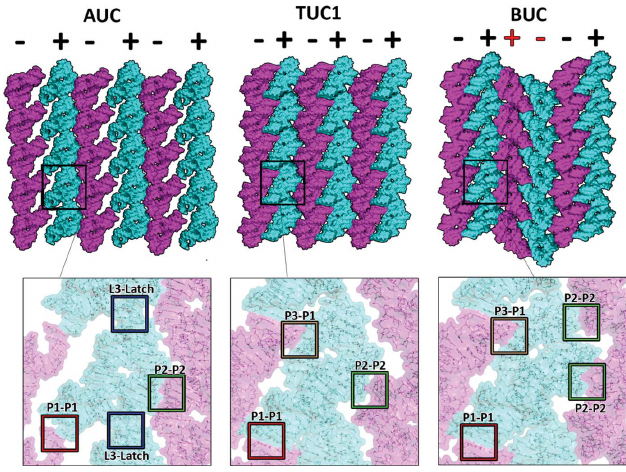
Figure 2 Comparison of the orientations of riboA molecules in the ac plane of each crystal phase, AUC (left), TUC1 (middle) and BUC (right), and their respective crystal packing interfaces. The lattice plane can be described as columns of riboA molecules, each of which has an associated direction (+ or (cid:5) ) based on the way the molecules are facing. Red + and – highlight the change in orientation of the columns in the BUC phase, relative to